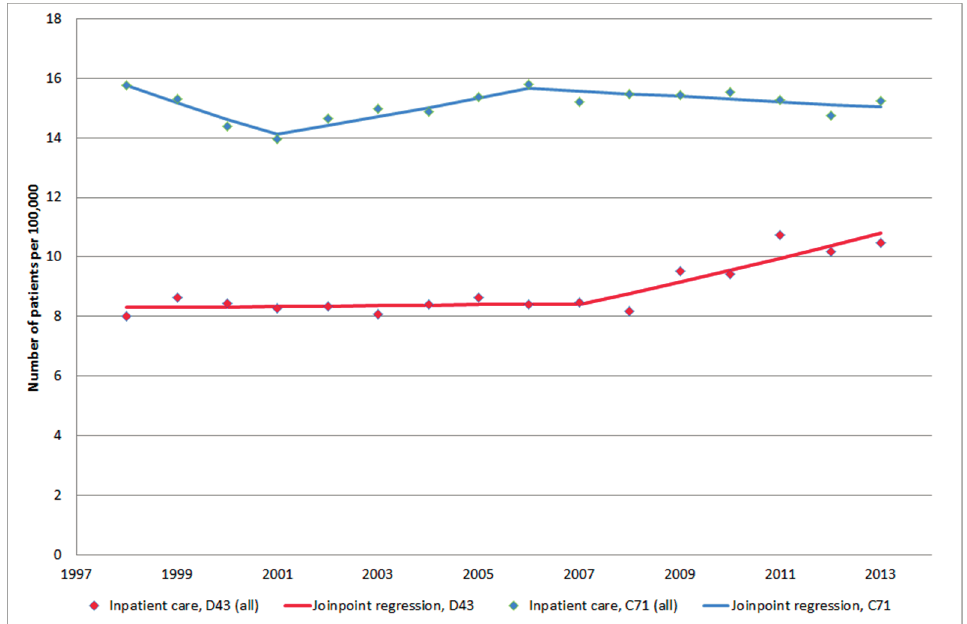
Figure 9. Joinpoint regression analysis of number of patients per 100,000 inhabitants according to the Swedish National Inpatient Register for both genders combined, all ages during 1998–2013 diagnosed with D43 = tumour of unknown type in the brain or CNS and C71 = malignant brain tumours